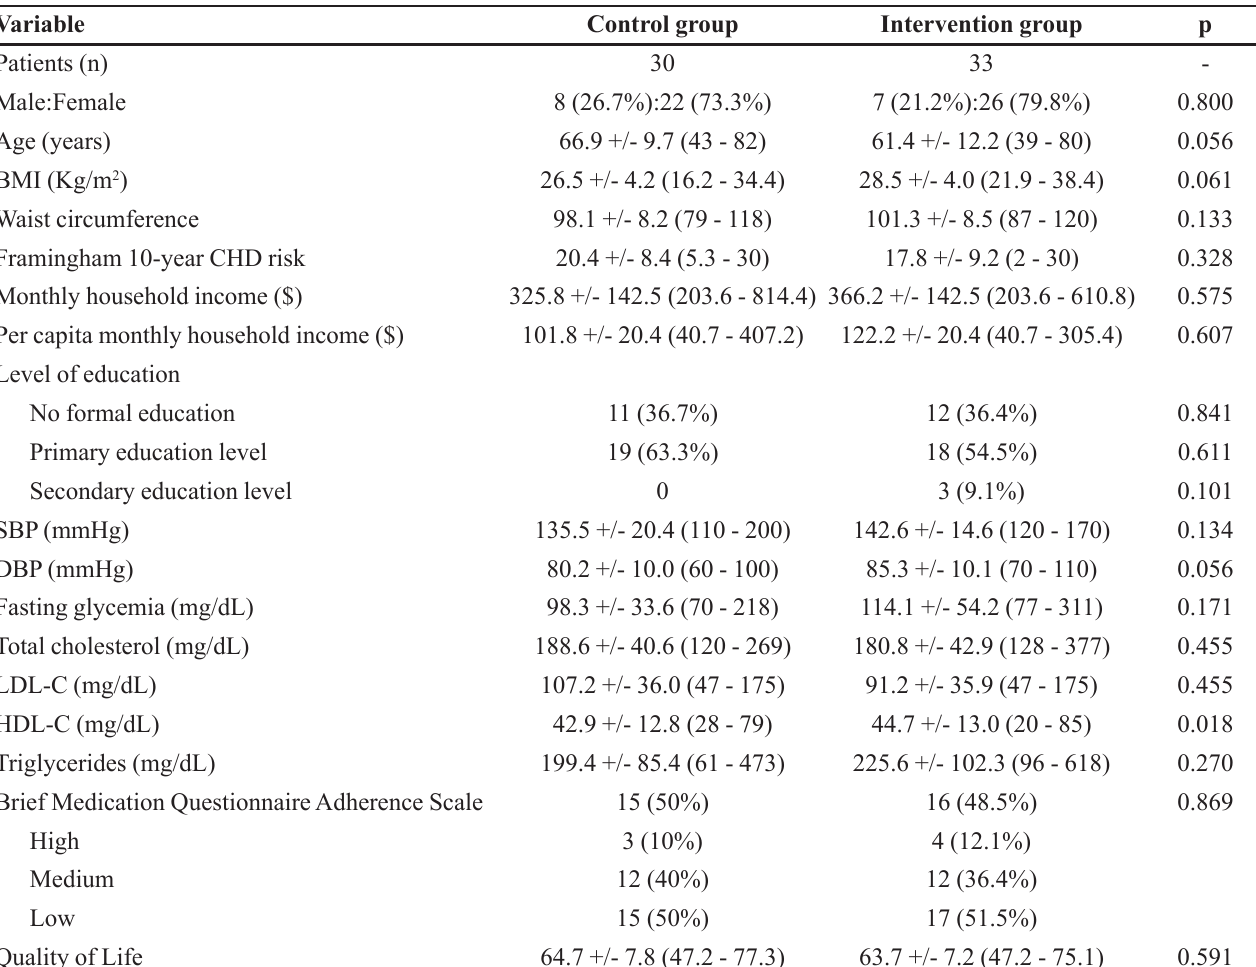
TABLE I - Baseline demographic and clinical characteristics of the studied patients in the control and intervention groups, n (%), mean ±